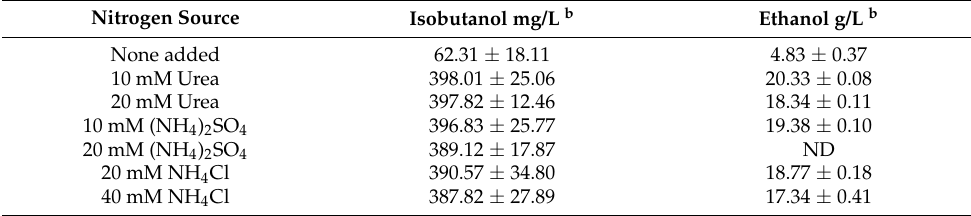
Table 2. Influence of nitrogen source on isobutanol and ethanol synthesis a .